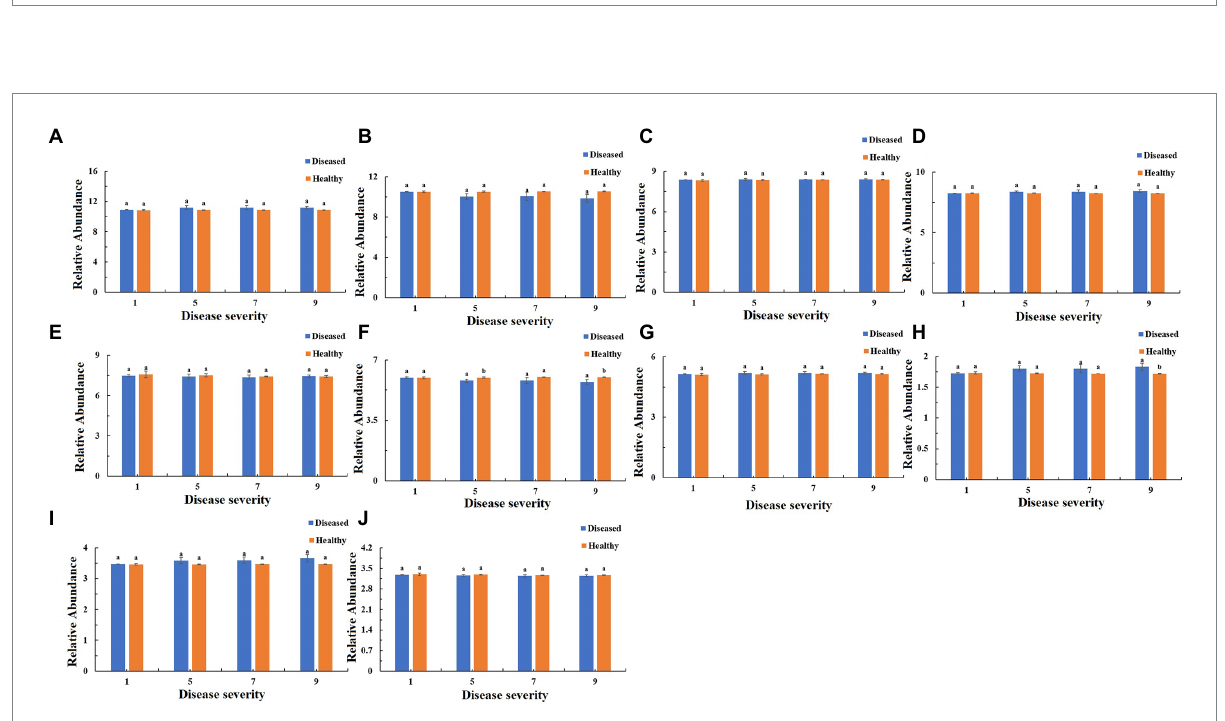
FIGURE 11 PICRUSt analyses of the changes in the KEGG level 2 functional categories of bacteria in tobacco leaf samples. (A) Membrane Transport, (B) Energy Metabolism, (C) Carbohydrate Metabolism, (D) Amino Acid Metabolism, (E) Replication and Repair, (F) Metabolism of Cofactors and Vitamins, (G) Poorly Characterized, (H) Translation, (I) Cellular Processes and Signaling, (J) Nucleotide